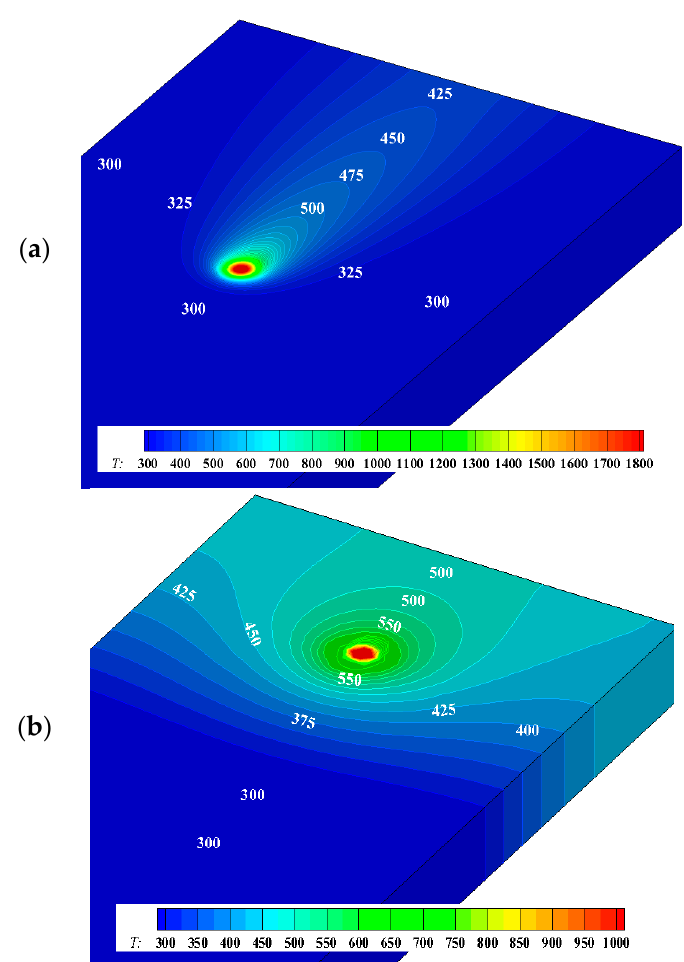
Figure 11. The numerical thermal fields for GTA welding in ( a ) stainless steel AISI 304L and ( b ) aluminum 6065 T5.